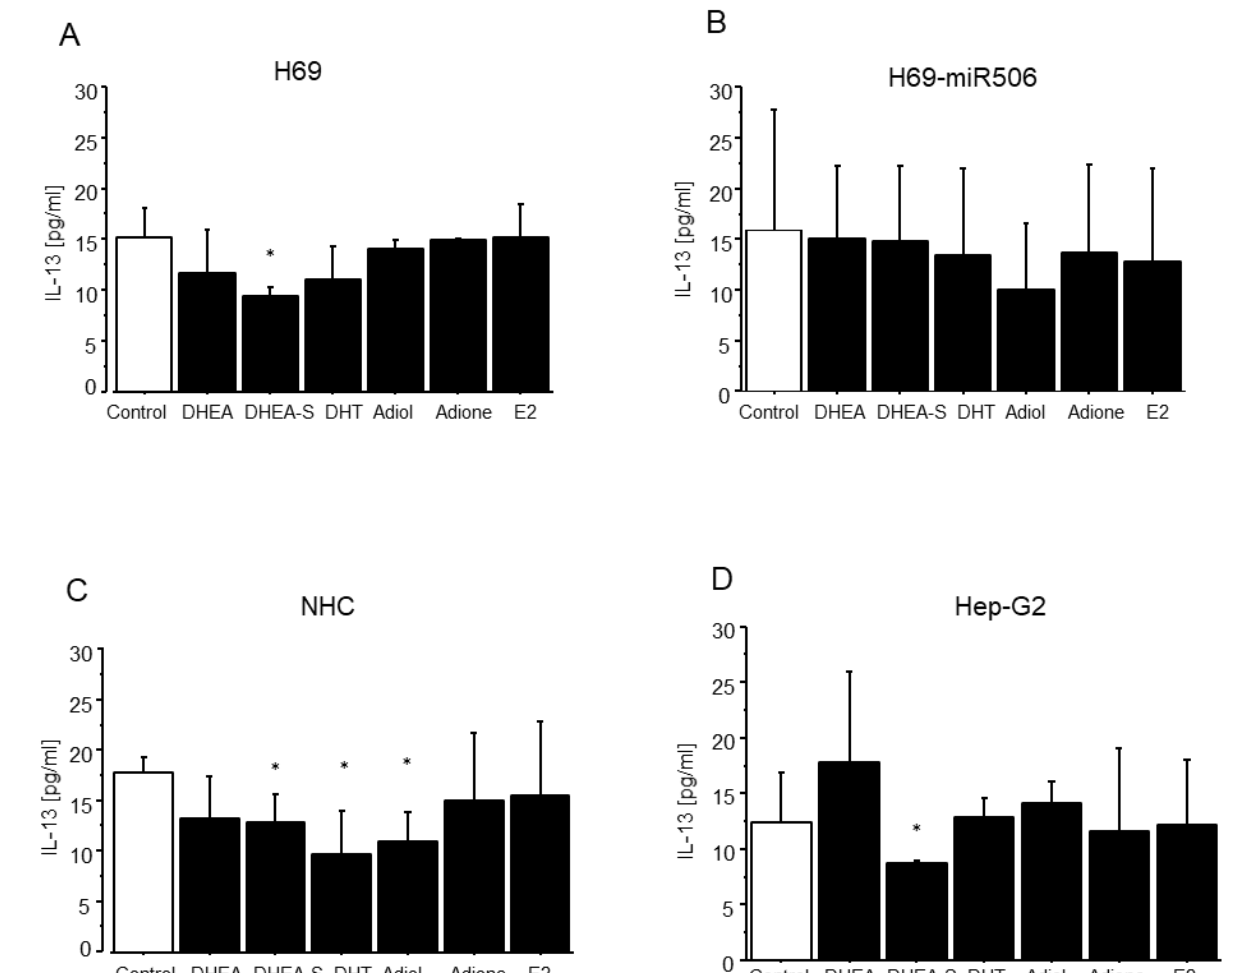
Figure 4. DHEA-S, DHT, and adiol affect the interleukin 13 level in normal human cholangiocytes (H69 and NHC) and hepatocytes (Hep-G2). Cells ( A – D ) were incubated with DHEA, DHEA-S, DHT, adiol, adione, and E2. After 24 h, the level of IL-13 was measured using an appropriate ELISA assay, * p < 0.05, n = 3.